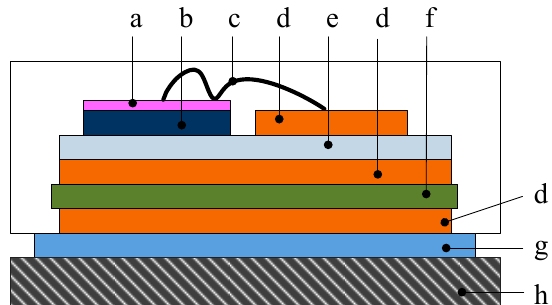
Figure 1. Cross-sectional view of base-plate free insulated gate bipolar transistor (IGBT) module with a heat-sink: ( a ) Aluminum metallization, ( b ) Chip, ( c ) Bond wire, ( d ) Copper pad, ( e ) Solder, ( f ) Ceramic subtracts, ( g ) Thermal grease, and ( h ) Heat-sink.